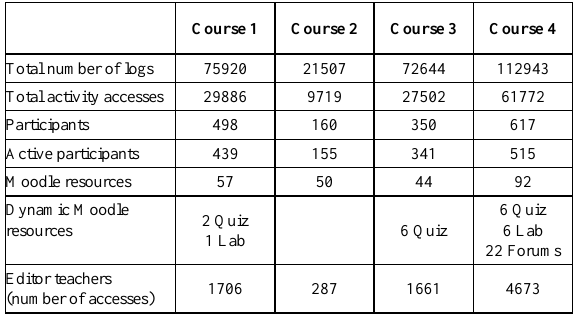
TABLE II. O VERVIEW OF M OODLE RESOURCES AND ACCESSES PER